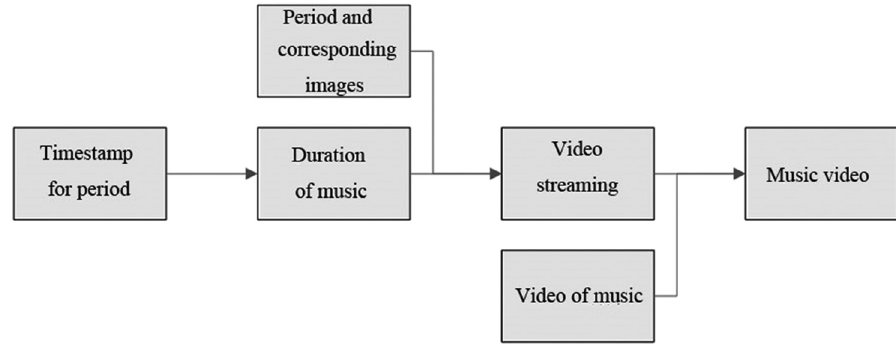
Figure 2: The synthesis process of music and